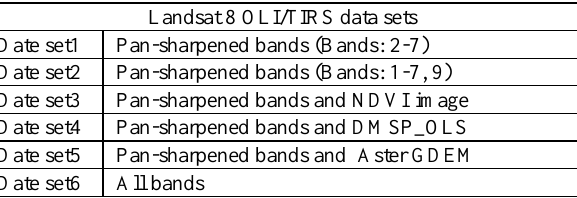
Table 2. The data sets showing band combination that used to RF classification of LANDSAT 8 OLI/TIRS